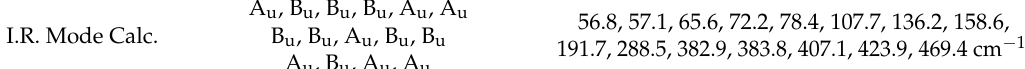
Table 1. Calculated vibrational modes and measured Raman modes for Au 2 P 3 . I.R. = infrared, N/O = not observed.